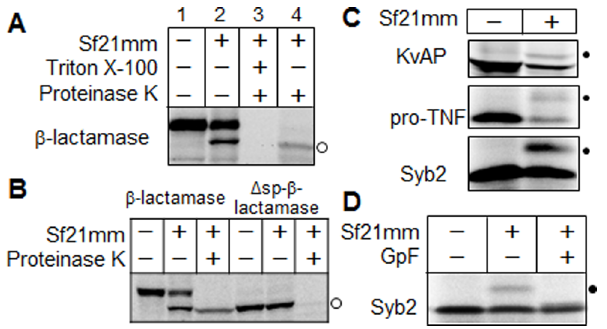
Fig. 2. Assessment of posttranslational modification of secreted proteins and membrane proteins synthesized using the cell-free system containing Sf21 microsomes. (A) Cleavage of the signal peptide of b -lactamase in microsomes. Translocation reactions containing E. coli b -lactamase labeled with FluoroTect Green Lys tRNA (12.5 m l) were mixed with 1 m l of sterilized water (lane 2), with 0.5 m l of 200 m g/ml proteinase K and 0.5 m l of 20% (v/v) Triton X-100 (lane 3) or 0.5 m l of 200 mg/ml proteinase K (lane 4). The samples were incubated for 1 h at 4 ˚ C. Equal volumes (6 m l) of the samples were separated by SDS-PAGE on 15% gels. The open circle marks the mature protein without the signal peptide. Lane 1 contains b -lactamase synthesized without microsomes as a control. (B) The N-terminal signal peptide sequence of b -lactamase is required for its translocation across the microsomal membrane. The E. coli b -lactamase lacking its signal peptide ( D sp- b - lactamase) and the wild type ( b -lactamase) were labeled with FluoroTect Green Lys tRNA (12.5 m l). The translocation reaction was performed as in panel A. (C) N-linked glycosylation of membrane proteins in the microsomes. Aeropyrum pernix voltage-dependent K + channel (KvAP), human pro-tumor necrosis factor (pro- TNF) and human synaptobrevin II (Syb2) were labelled with 35 S-methionine during translation in the presence ( + ) or absence (-) of Sf21 microsomes. Dots indicate the glycosylated form of the proteins. (D) Confirmation of N-linked glycosylation of Syb2 labeled with 35 S-methionine. One m l of 10% (v/v) Triton X-100 and 1 m l of 500 mU/ml glycopeptidase F (GpF) were added to the translation mixture (12.5 m l), followed by incubation for 5 min at 37 ˚ C. The dot indicates the glycosylated protein.